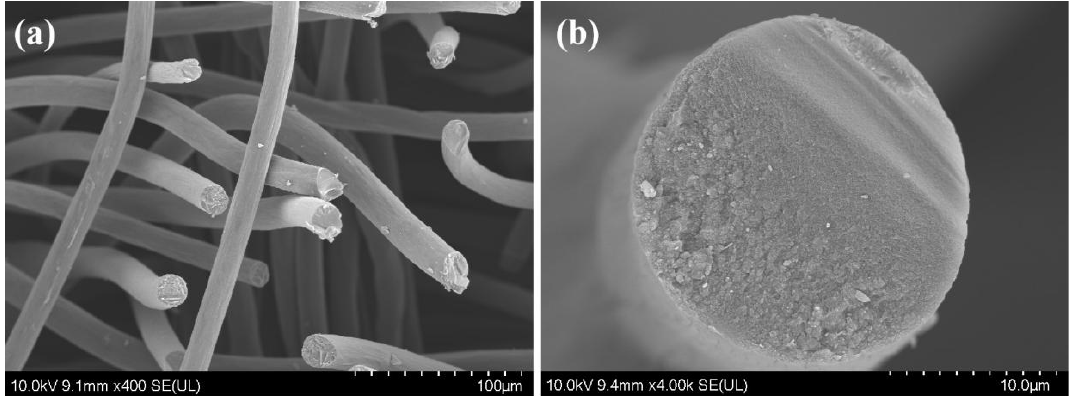
Figure 2. FE-SEM images of ( a ) the prepared C-fiber fabric and ( b ) the cross-section of